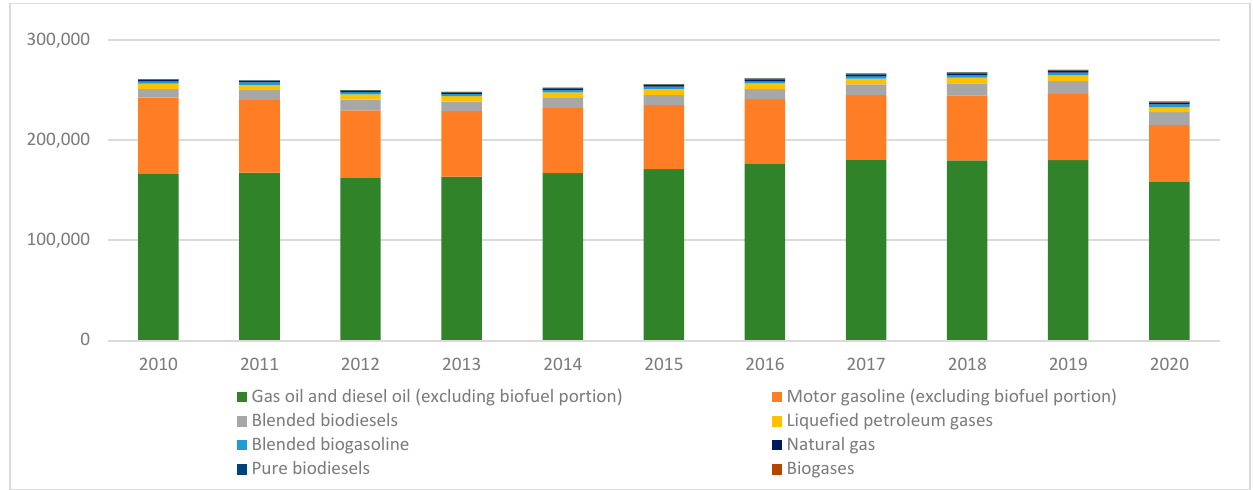
Figure 7. Final energy consumption in road transport by type of fuel in EU-27 (Mtoe). Source: Own elaboration based on Eurostat 2022.